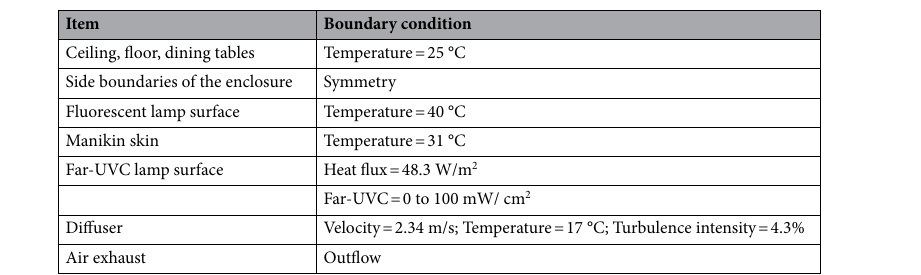
Table 2. Boundary conditions for numerical modeling in a dining